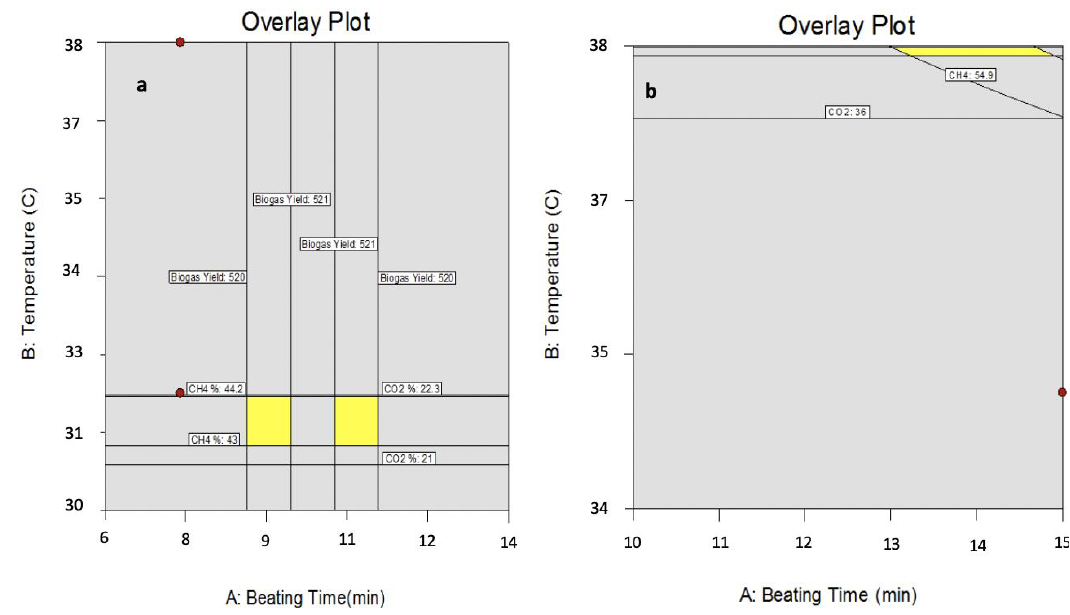
Figure 11. Graphical optimisation for AD of pot ale ( a ) and AD of spent grain pot ale mix ( b ).